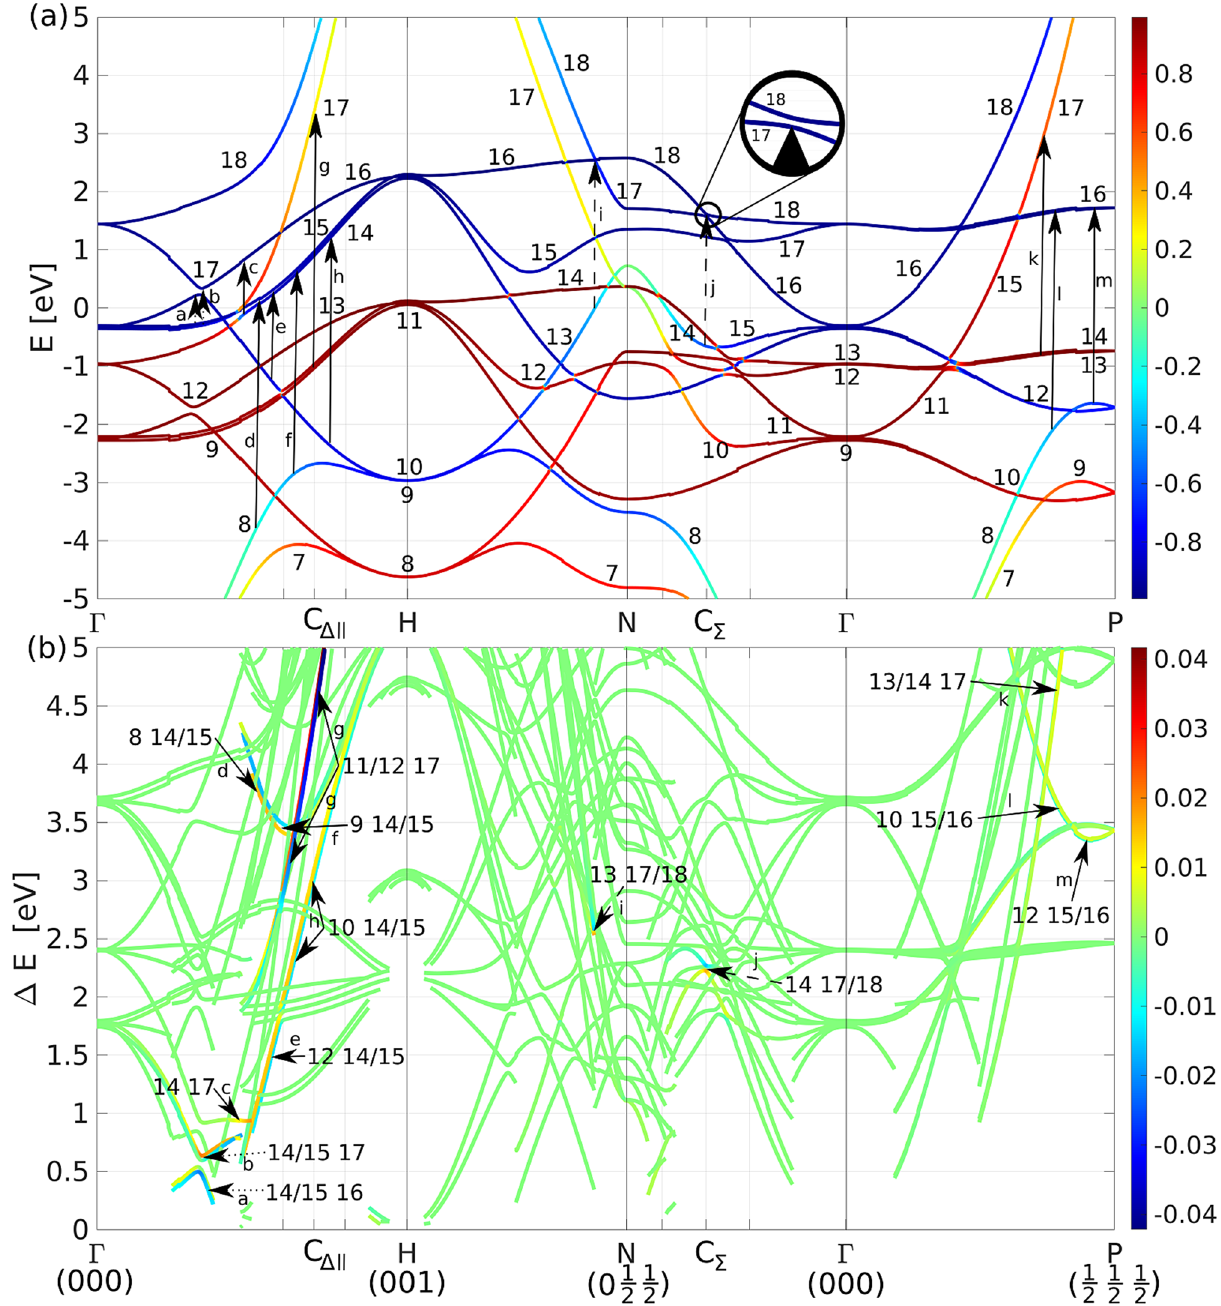
Figure 3. ( a ) Band structure with colors corresponding to the d -character of bands with spin-up being positive and spin-down negative. Arrows indicate individual magneto-optical transitions. Fermi level is at 0 eV. ( b ) Joint band structure with colors representing the imaginary part of the product of momentum matrix elements for respective pair of bands Im [� i | p x | f �� f | p y | i �] . Strong transitions are labeled by their respective band indices in correspondence with ( a ). Since they come in pairs, three bands are generally involved in a single transition. Strong 2D MO transitions are marked by dashed arrows and 1D transitions by solid arrows. Transitions a and b are marked by dotted lines as special case. The initial bands involved in these transitions are 1D-split while the final bands are 2D-split. SO splitting of bands 17 and 18 at C (cid:31) is zoomed